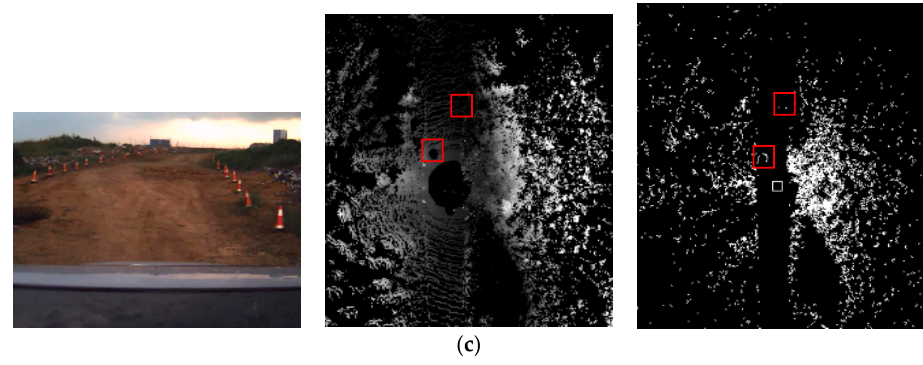
Figure 18. Ground segmentation under various environments. ( a ) Congested viaduct; ( b ) Urban road with obstacles; ( c ) Off-road scene with negative obstacles.